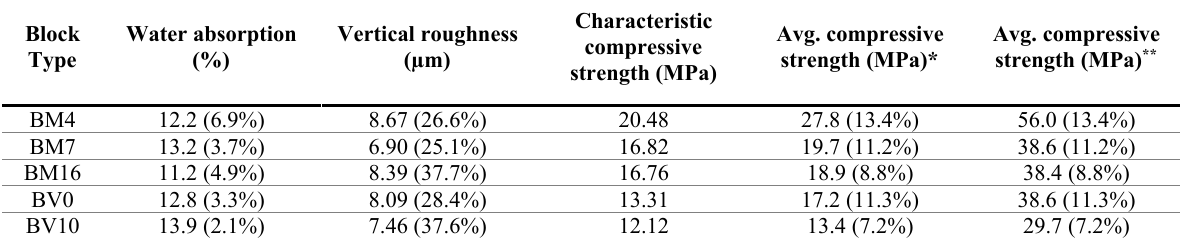
Table 2. Properties of the